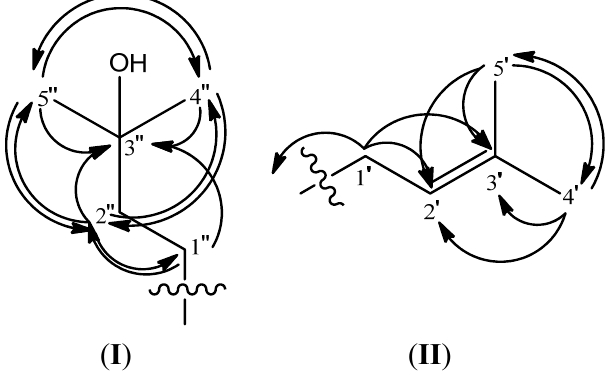
Figure 2. The HMBC correlation of 3-hydroxy-3-methylbutyl ( I ) and prenyl ( II ) moieties in compound 1